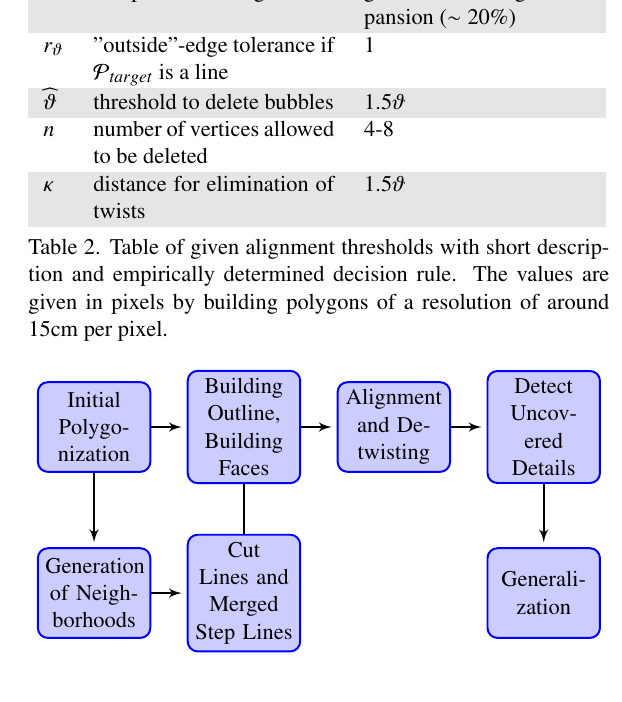
Figure 8. Workflow of the proposed method from the initial poly- gon to the generalized output. The building outline as well as cut lines and step lines serve as target polygons, the initial polygo- nization of the building faces serve as trigger